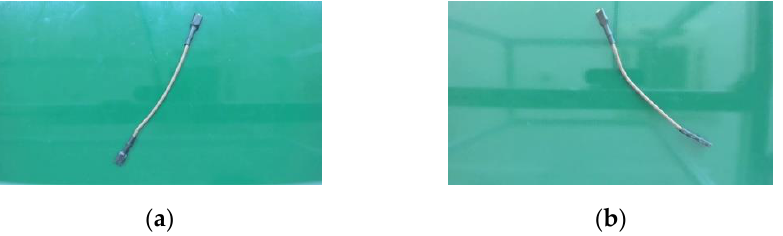
Figure 5. Satisfactory electrical wire connectors under different levels of lighting. ( a ) Low level of lighting; ( b ) High level of lighting.